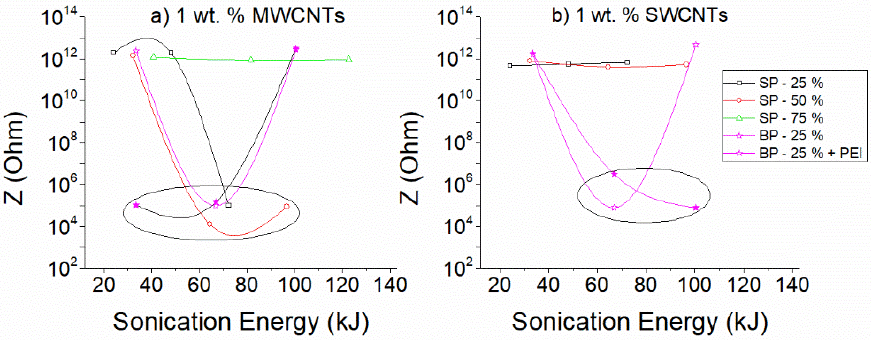
Figure 8. Variation of |Z| values at a frequency of 0.05 Hz as a function of sonication energy of aqueous dispersions of ( a ) MWCNTs 1 wt.% and ( b ) SWCNTs 1 wt.%. Note that SP stands for small and BP for big probe; P stands for PEI.